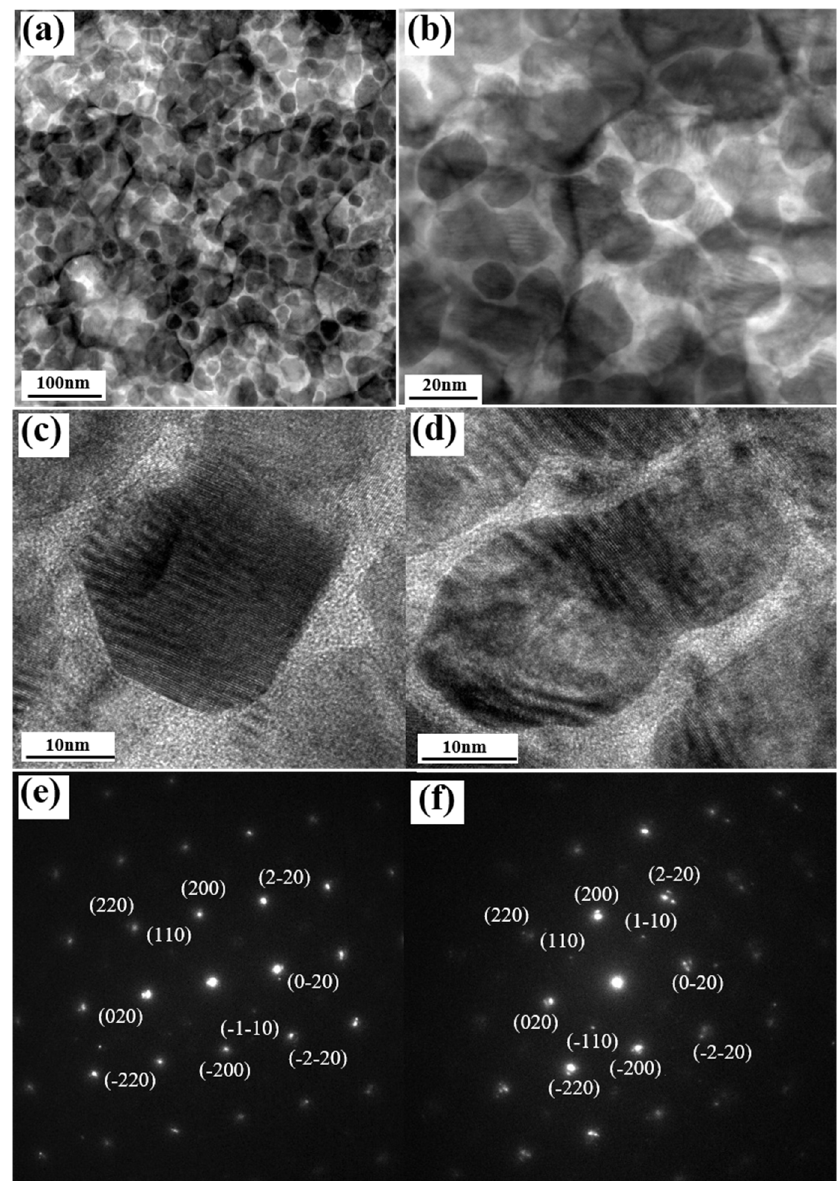
Figure 7. ( a , b ) The plane view TEM images of FePt-(B, Ag, C)(8 nm)/MgTiON/CrRu film, ( c , d ) magnified TEM images of ( a , b ), ( e ) nano-beam diffraction pattern of isolated FePt grain in ( c ), ( f ) nano-beam diffraction pattern of interconnected FePt grain in ( d ).